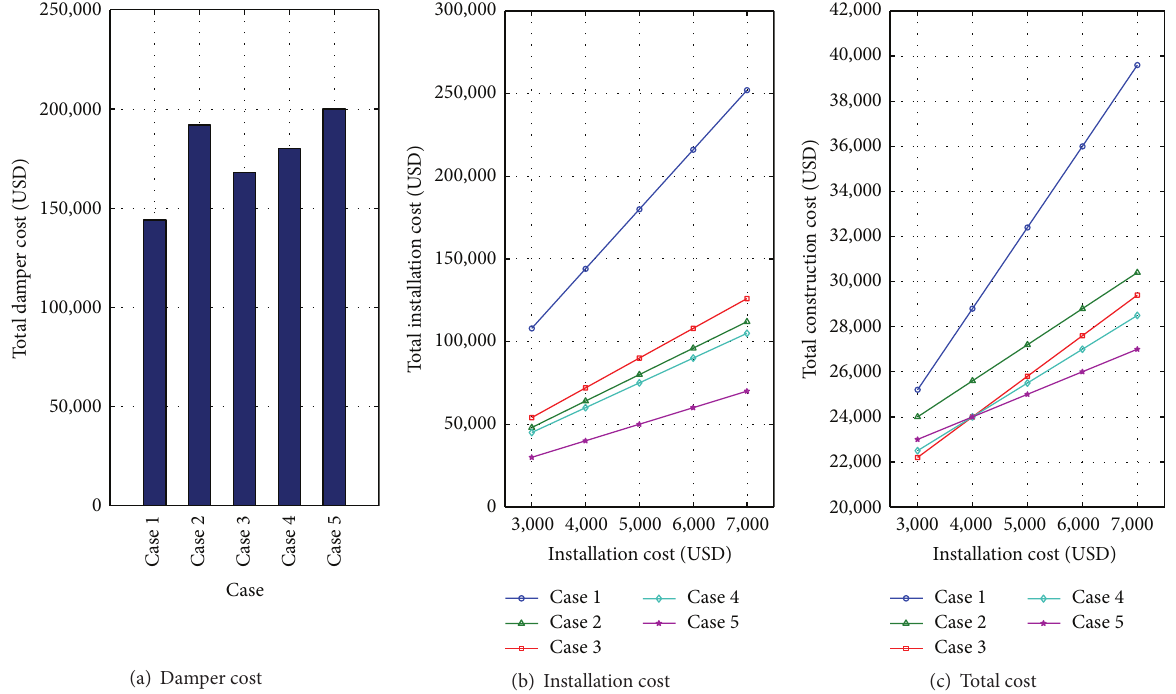
Figure 10: Cost of MSD systems (Case 1 ∼ Case